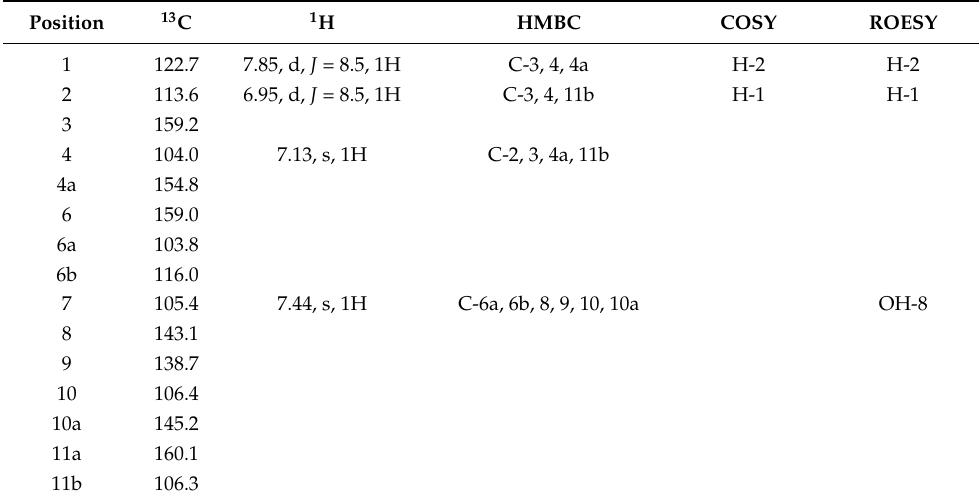
Table 1. 1 H (700 MHz), 13 C (175 MHz), HMBC, COSY, and ROESY NMR data for compound 10 ( δ in ppm, J in Hz, CDCL 3